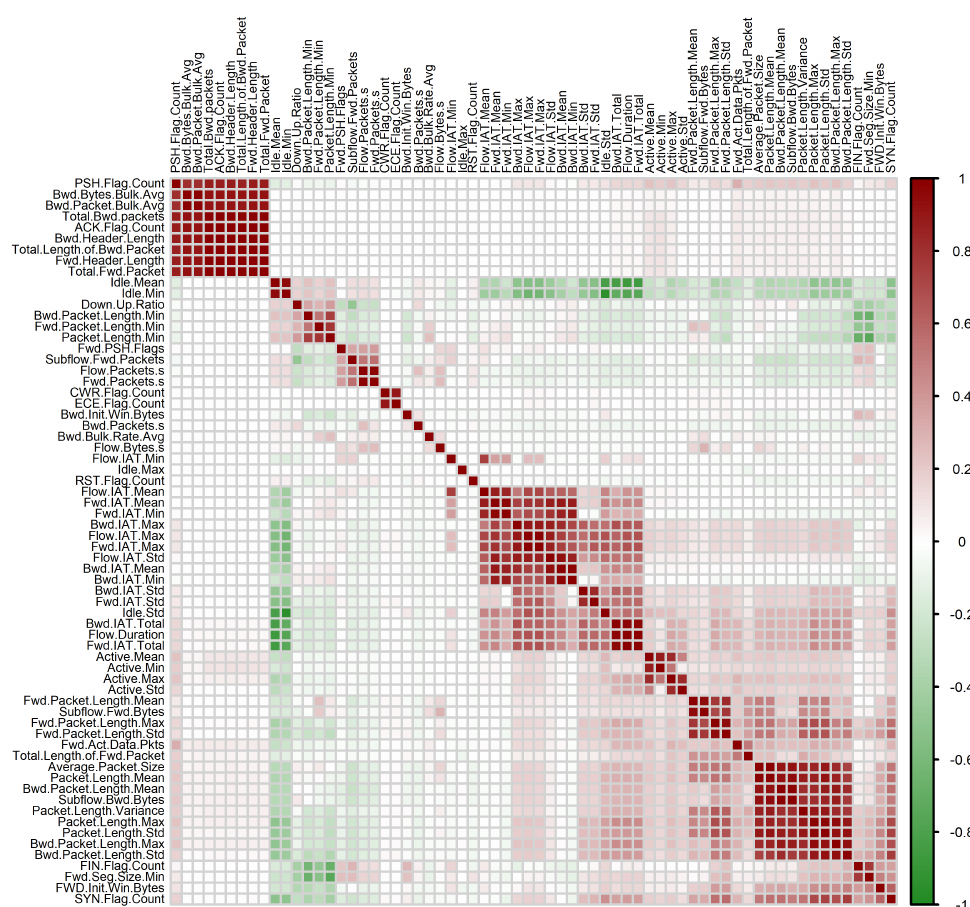
Figure 4. Pearson correlations of 66